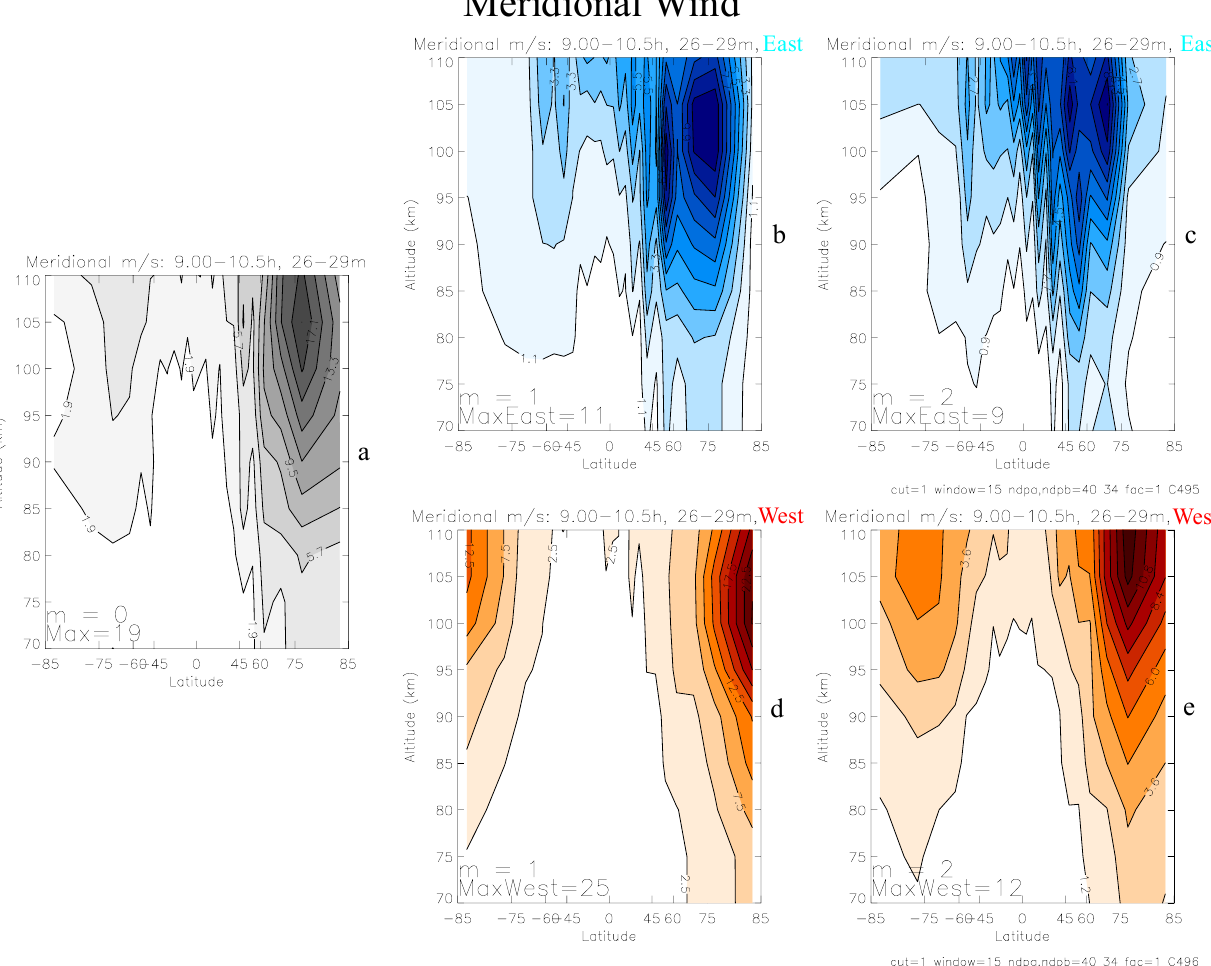
Fig. 3. Maximum meridional wind amplitudes of stationary m=0 wave ( a ) , and eastward ( b , c ) and westward ( d , e ) propagating waves (m=1, 2) for periods from 9 to 10.5h, computed with a running window of 15 days from the time span of 26 to 29 months (March through May of the third model year). Contour plots are presented versus height and latitude, applying the Mercator projection to expand the regions at high latitudes where the waves are prominent. In each panel, the largest amplitudes from the contours are